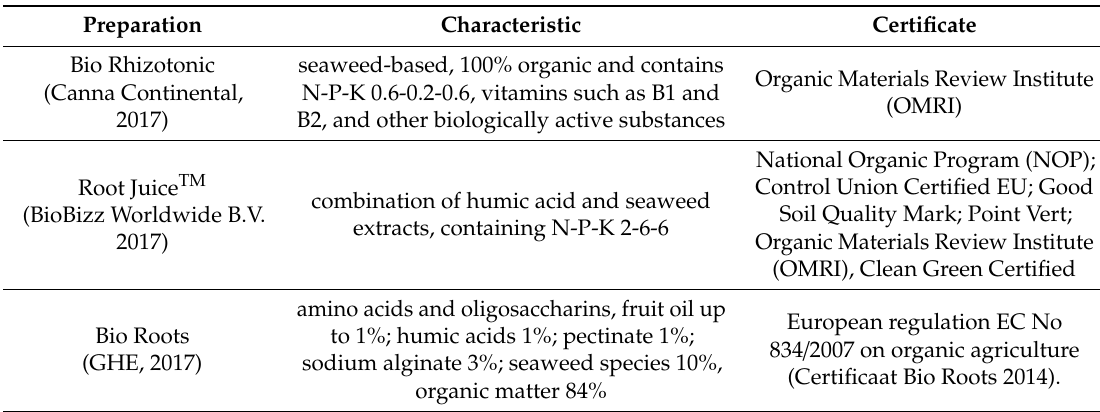
Table 1. Plant origin preparations used to root Rosa × alba ‘Maiden’s Blush’ in the experiment.